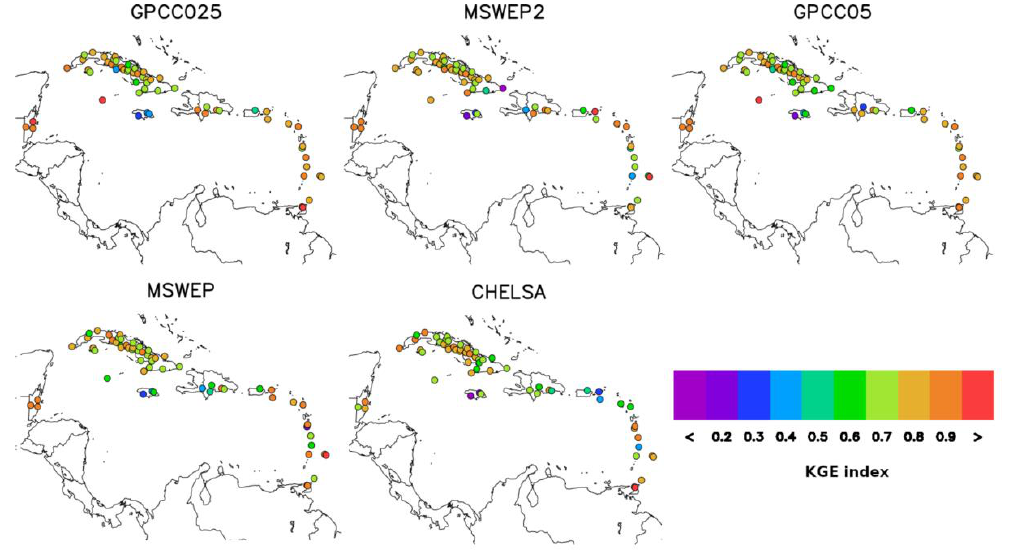
Figure 5. Spatial distribution of KGE scores for GPCC025, MSWEP2, GPCC05, MSWEP, and CHELSA. Colors for KGE range from violet to red, representing very poor to optimum skill respectively. Diagrams ordered according to median annual performance (see Figure 3). Table 2. Mean median KGE components scores. Bias, Correlation and Variability are expressed as | B − 1|, | R − 1| and | V − 1|, respectively (see Equation (1)).